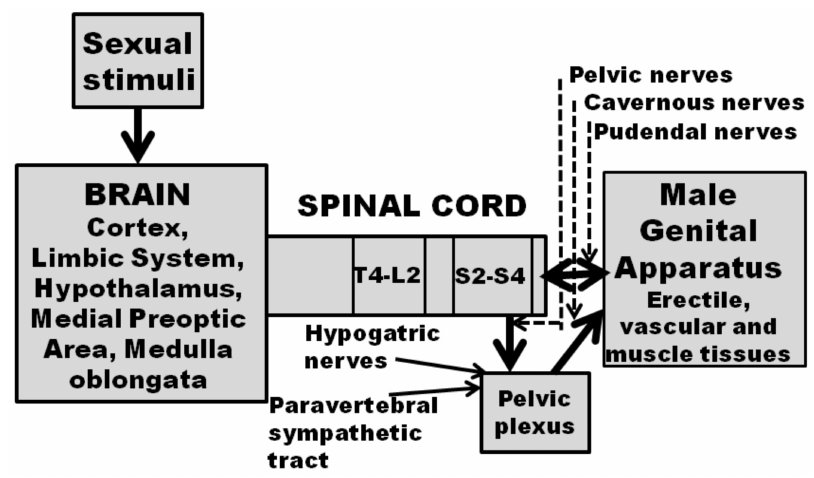
Figure 1. A simplified representation of the neural pathways that control penile erection and male sexual behavior. When sexual (visual, auditory, olfactory, tactile and even imaginative in man) stimuli reach the brain’s high centers, these activate neural pathways (to date still unknown), which lead to penile erection, the key event for copulation/sexual intercourse. These travel from the brain, mainly from the hypothalamus and its nuclei (i.e., paraventricular nucleus) and medial preoptic area, along the medulla oblongata and the spinal cord, to the genital apparatus. The latter is innervated by pudendal nerves that originate from the sacral (S2–S4) spinal tract and in which run the primary afferent sensory from and motor pathways to the penis, and by cavernous nerves in which run the primary efferent sympathetic and parasympathetic pathways originating in the pelvic plexuses. These receive neural inputs from pelvic nerves originating in the sacral (S2–S4) spinal tract, from hypogastric nerves that originate in the thoracic-lumbar (T4–L2) spinal tract and post-gangliar fibers that originate from the paravertebral sympathetic ganglia of the thoracic-lumbar tract of the spinal cord (T11–L2) (for references see